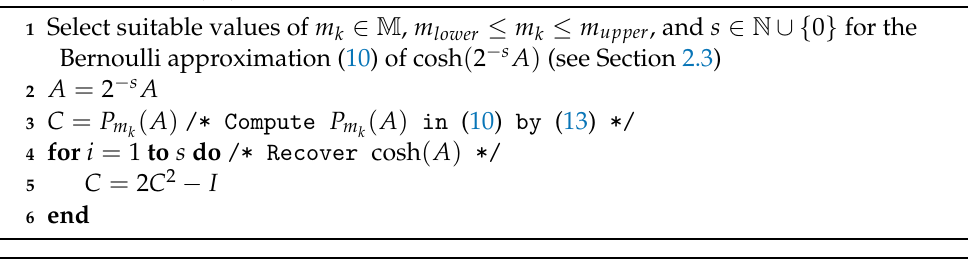
Algorithm 2: Given a matrix A ∈ C r × r , a minimum order m lower ∈ M and a